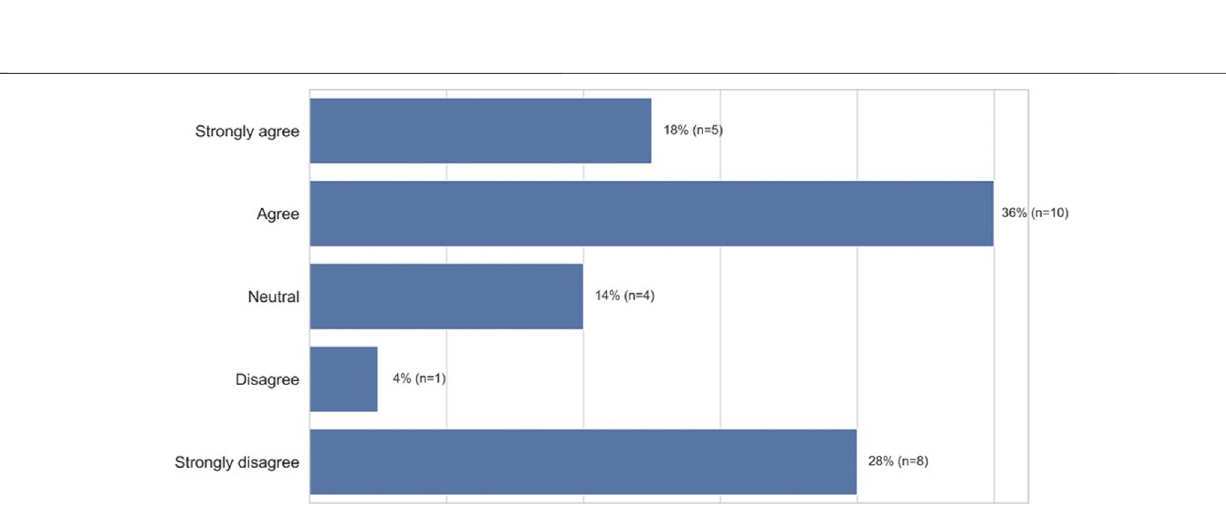
Frontiers in Arti fi cial Intelligence |